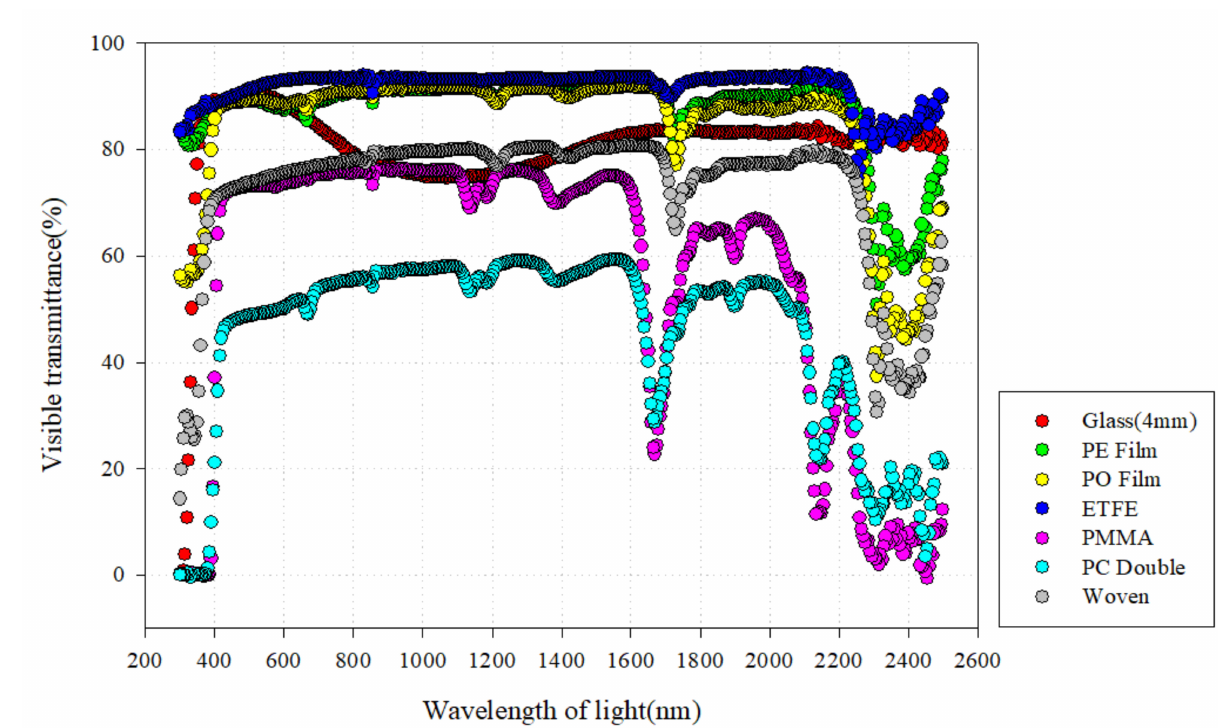
Figure 12. Comparison of visible transmittance by sample.